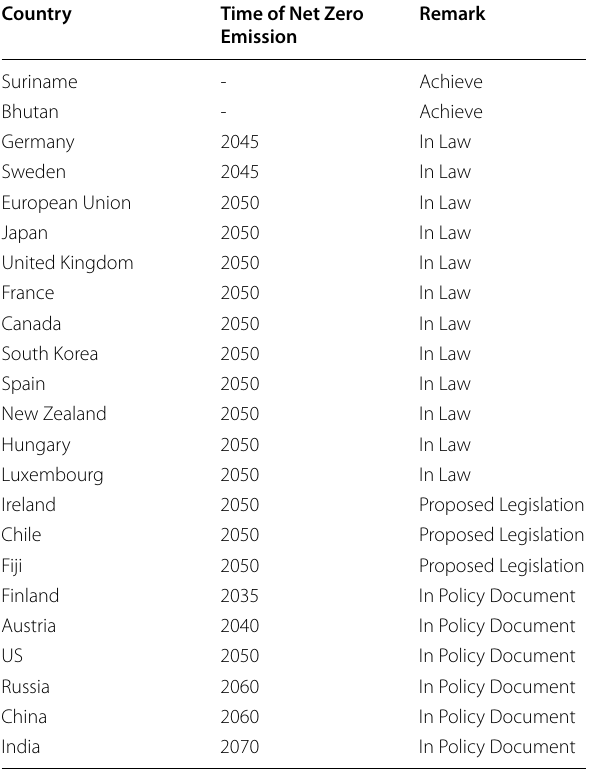
Table 2 Time of Net Zero Emission Commitment